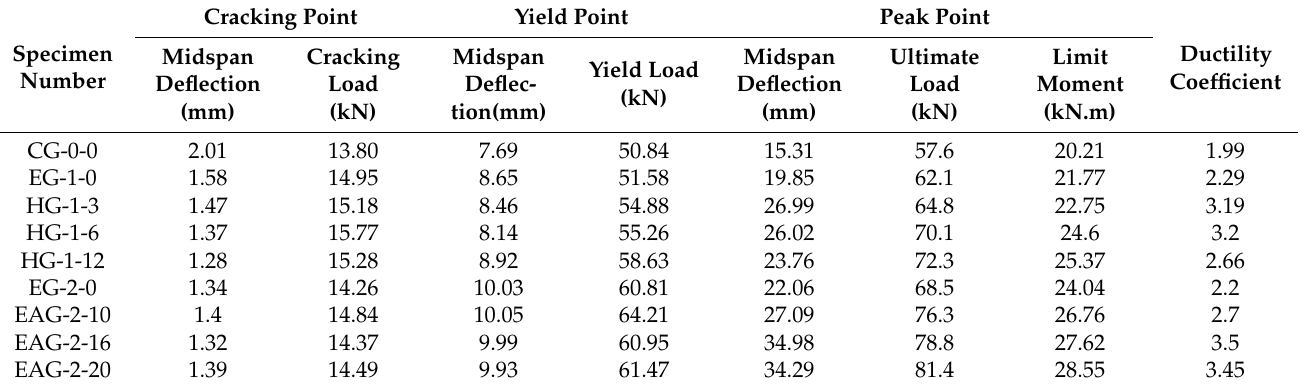
Figure 5. Comparison of load-deflection curves of FRP-reinforced test beams: ( a ) middle anchorage and ( b ) end anchoring. Table 4. Specimen numbers and strengthening